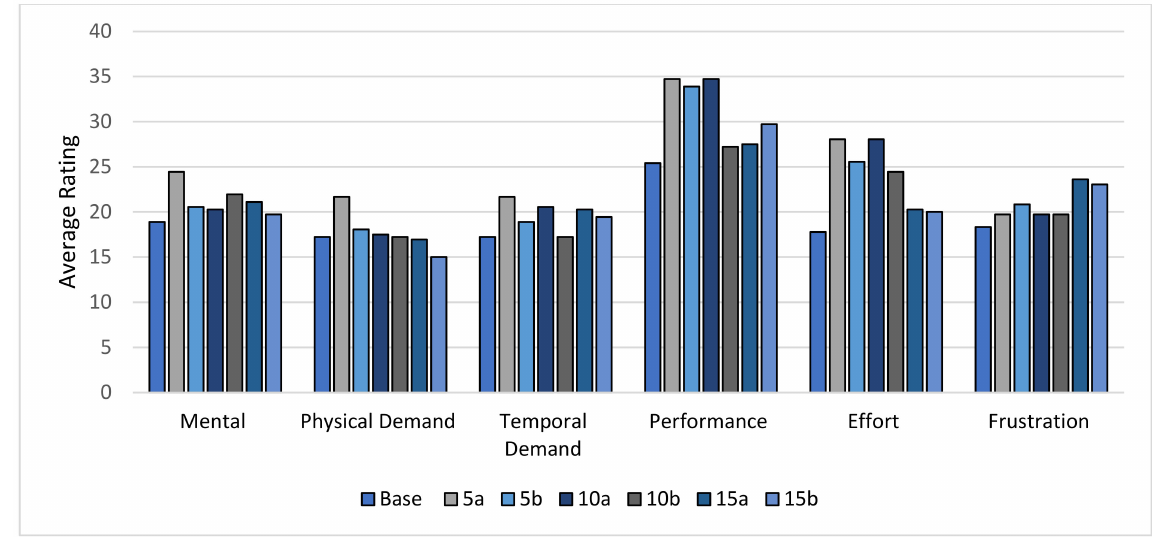
Figure 13. Average rating of NASA-TLX for an ego vehicle session.